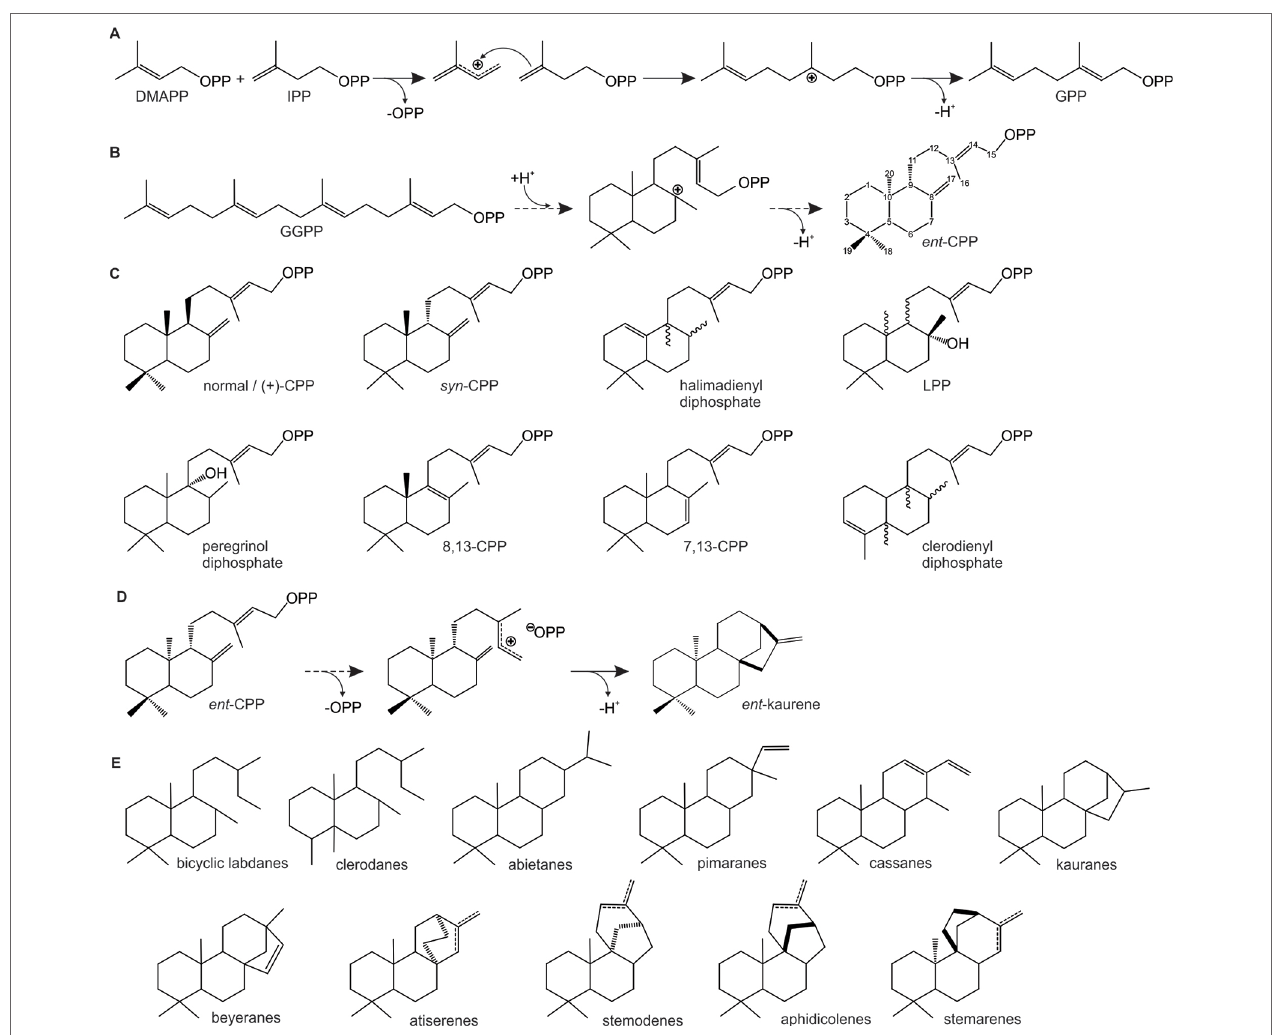
FIGURE 2 | Schematic overview of representative carbocation-driven reactions catalyzed by prenyl transferases (PTs) and diterpene synthases (TPSs). (A) PT catalyzed head-to-tail condensation of isopentenyl diphosphate (IPP) with its positional isomer dimethylallyl diphosphate (DMAPP) via ionization of the allylic diphosphate ester bond (OPP) and subsequent coupling between the resulting carbocation and the C3–C4 double bond of IPP. Deprotonation of the carbocation intermediate yields geranyl diphosphate (GPP). (B – C) Conversion of geranylgeranyl GGPP by class II diTPSs using protonation-initiated cyclization of GGPP to facilitate scaffold rearrangement into bicyclic prenyl diphosphates of ent -copalyl diphosphate ( ent -CPP) (B) and related scaffolds of distinct stereochemistry and hydroxylation (C) . (D – E) Class I diTPS-catalyzed conversion of bicyclic prenyl diphosphate intermediates via ionization of the diphosphate moiety and subsequent cyclization and rearrangement through various 1,2-hydride and methyl migrations to form, for example, ent -kaurene (D) and a range of other labdane diterpene scaffolds (E)